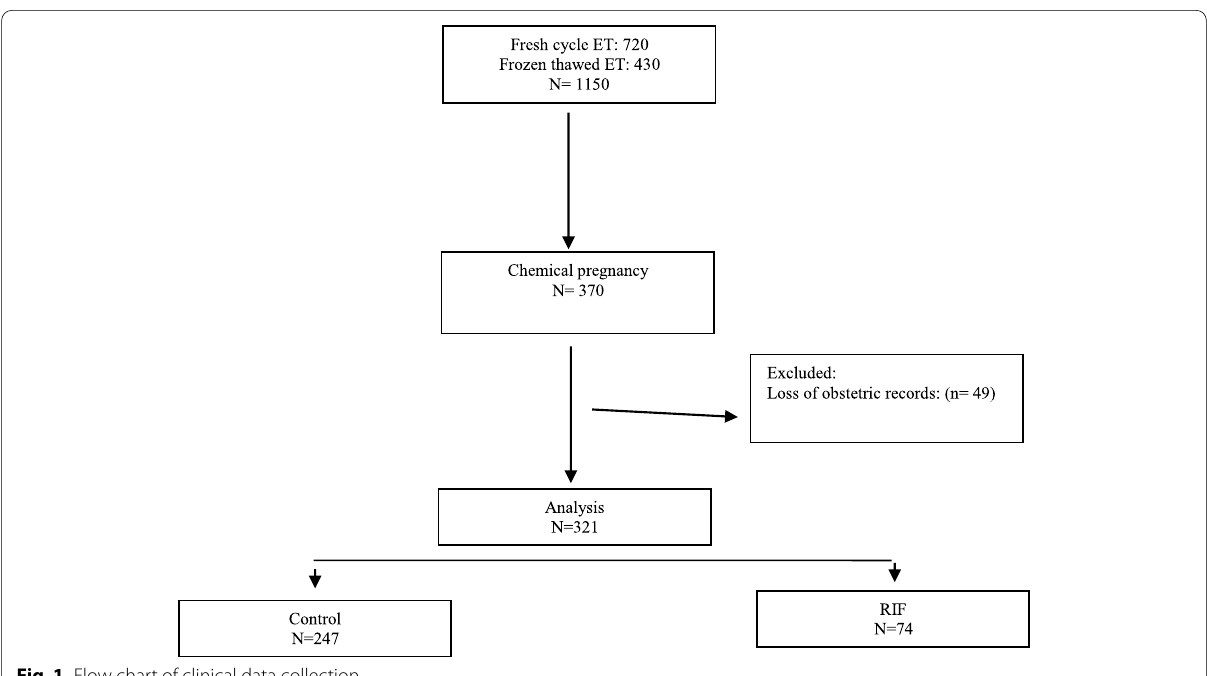
Fig. 1 Flow chart of clinical data